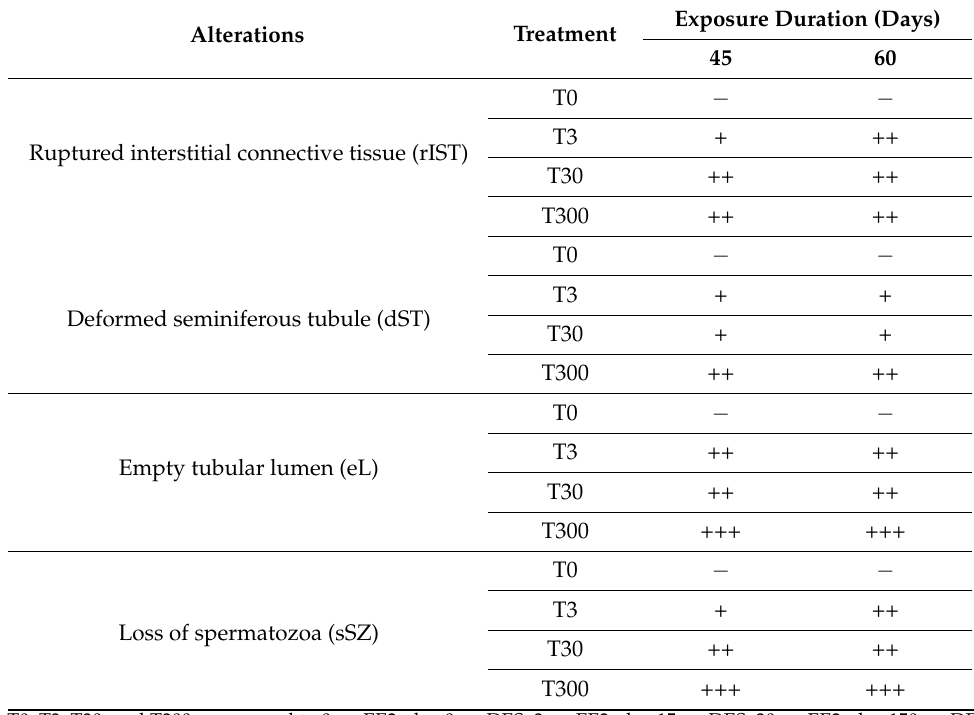
Table 3. Summary of histopathological alterations of climbing perch testes exposed to different concentrations of ethinylestradiol/desogestrel mixtures.